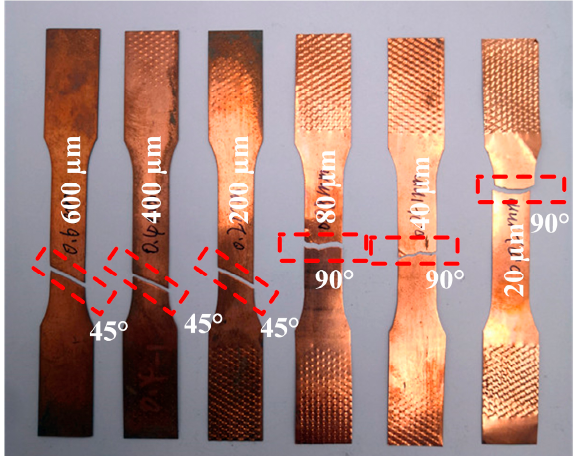
Figure 4. Fracture angle of tensile tested specimens of different thicknesses.